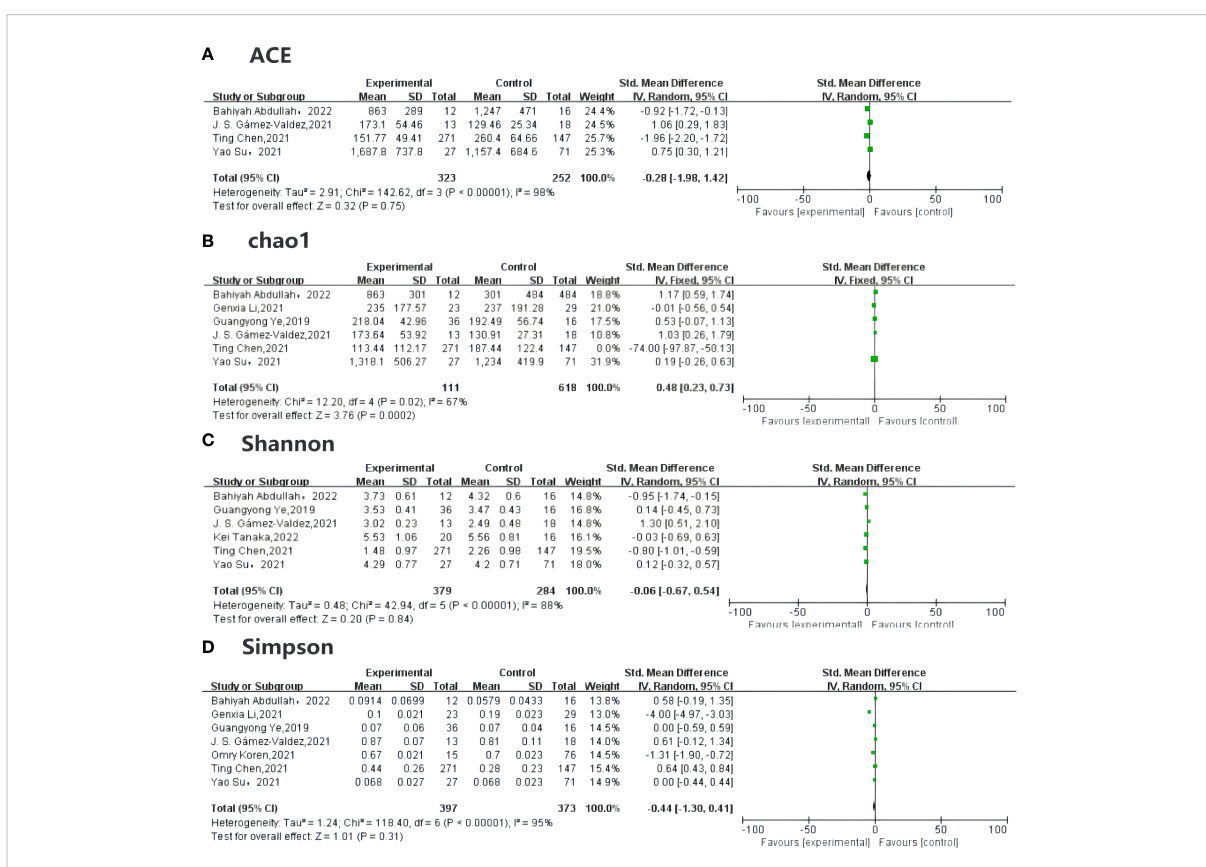
FIGURE 3 Forest plot of randomized controlled trials comparing the alpha diversity between GDM and NGDM. (A) plot means SDs of ACE, (B) plot described the Chao1between articles, and (C) plot indicates the result for Shannon index, (D) plot mentioned the Simpson index, which are all reported in studies. Differences between groups are presented as weights (percentages) and SMD (95% CI). CI, con fi dence interval; IV, inverse variance; SD, standard deviation; SMD, standardized mean